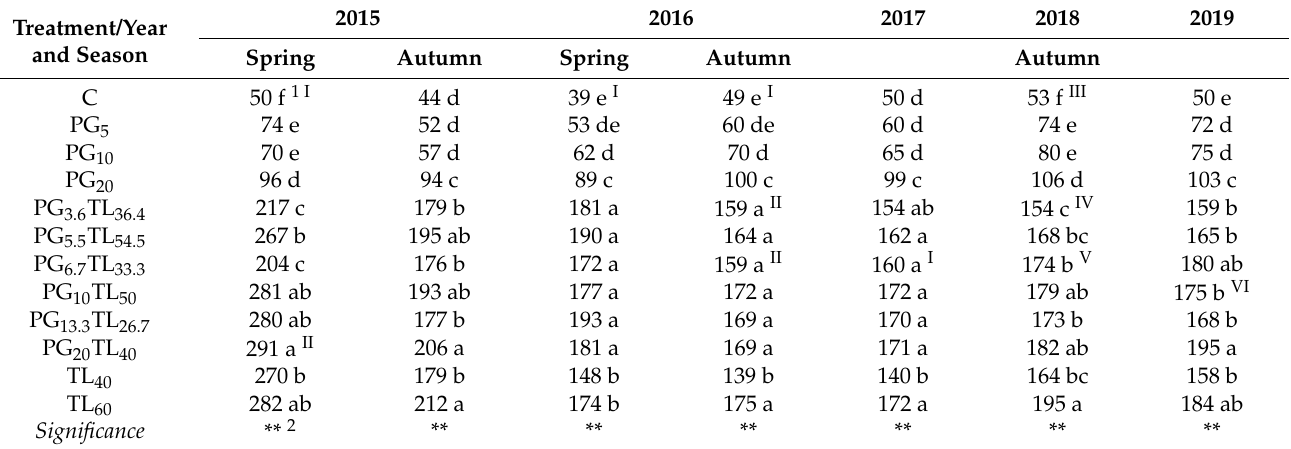
Table 13. Effect of treatments and years on the content of available phosphorus (P av , mg kg –1 ) at 0–20 cm soil